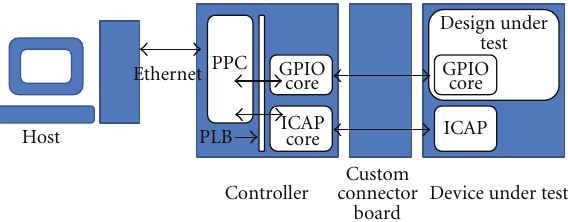
Figure 1: A block diagram of our fault injection system.